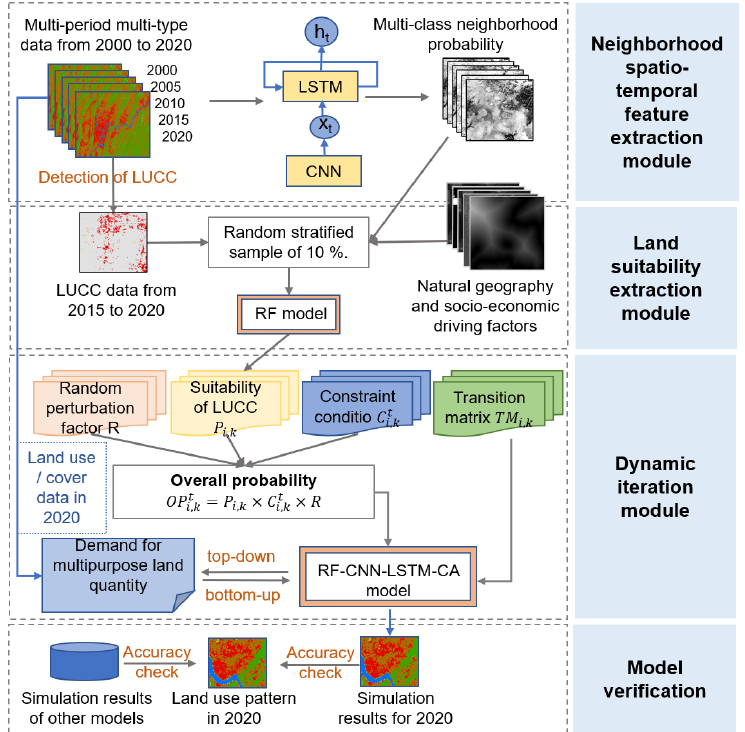
Figure 3. Flowchart of RF-CNN-LSTM-CA model.